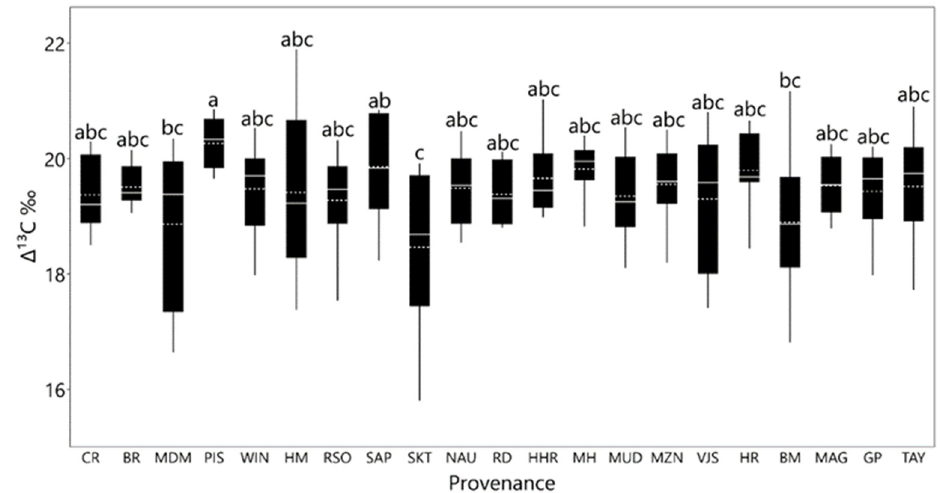
Figure 5. Leaf carbon isotope discrimination ( ∆ 13 C) by provenance averaged over the mid and high elevation sites (Ordered by elevation). Dashed lines are mean and solid lines are the median. Means followed by the same letter do not differ significantly (Tukey’s HSD tests; α = 0.05).